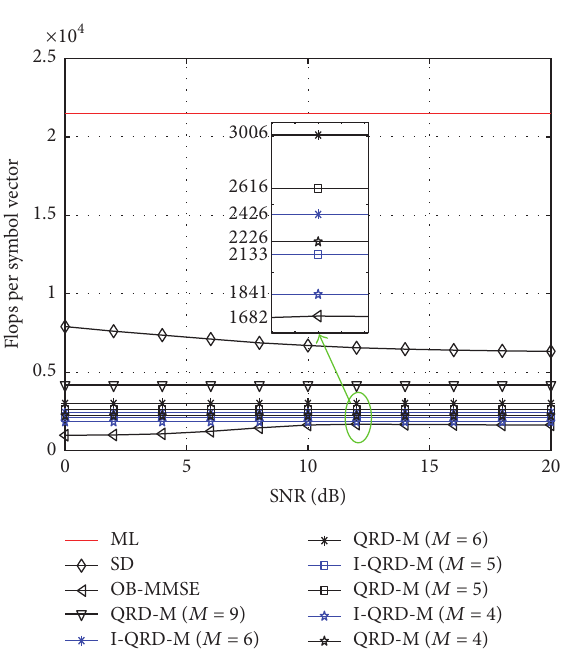
Figure 4: Computational complexity comparison for GSM scheme with 𝑁 𝑡 = 4 , 𝑁 𝑟 = 4 , and 𝑁 𝐴 = 3 for 4-QAM.